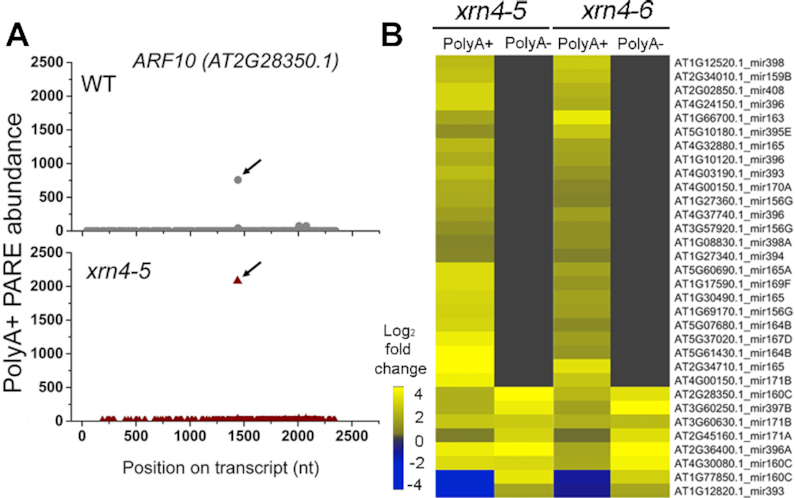
Most 3′ fragments of cleaved miRNA targets overaccumulate in xrn4 as polyadenylated RNA. (A) Decay plots (D-plots) of a validated miRNA target transcript ARF10 that overaccumulates 3′ fragment of miR160-guided cleavage in xrn4–5. Black arrow, miRNA-guided cleavage site. (B) The heat map of miRNA targets shows fold changes of 3′ fragment abundance in xrn4 in polyA+ and polyA- PARE (Supplementary Table S3). Abundance at cleavage site (±1 nt) in both xrn4 mutants ≥ 10 TP20M and ≥1.5-fold change.